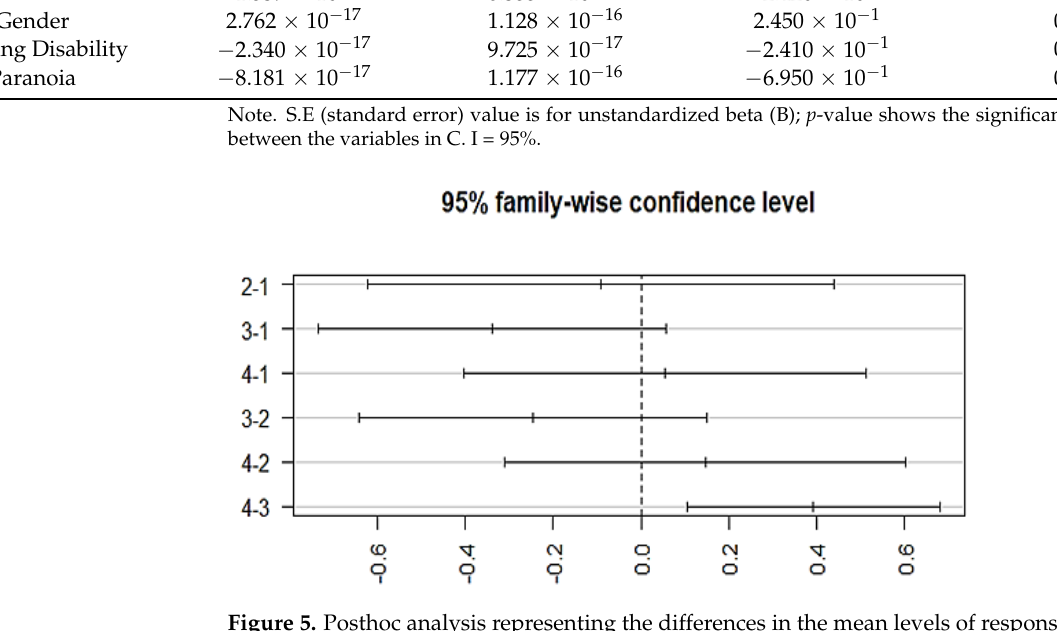
Figure 5. Posthoc analysis representing the differences in the mean levels of response to medication by typical antipsychotics. X-axis indicates the categorization of different groups based on the medi- cation response. (Group-1) No response, (Group-2) temporary slow response, (Group-3) response followed by the worst episodic attacks, (Group-4) completely recovered. (2-1)Difference in response to medication between group 2 and 1, (3-1) difference in response to medication between group 3 and 1, (4-1) difference in response to medication between group 4 and 1, (3-2) difference in response to medication between group 3 and 2, (4-2) difference in response to medication between group 4 and 2, and (4-3) difference in response to medication between group 4 and